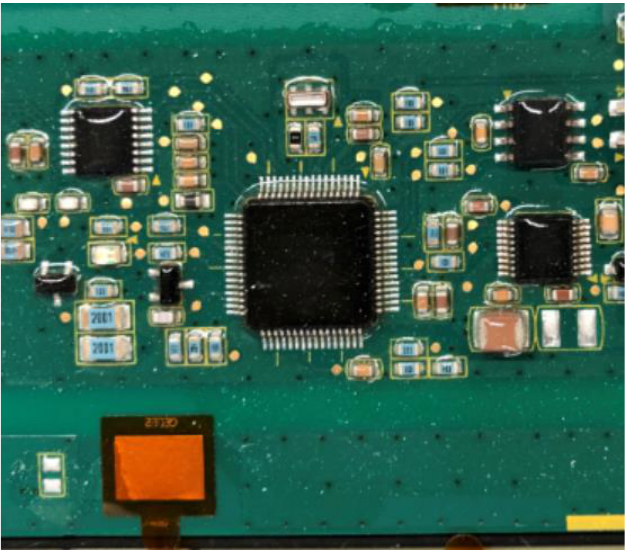
Figure 18. PCB coated with Conformal Coating B, passing 3 rounds of 517 thermal shocks followed by 517 cycles of thermal cycling without cracking, as described in the text.